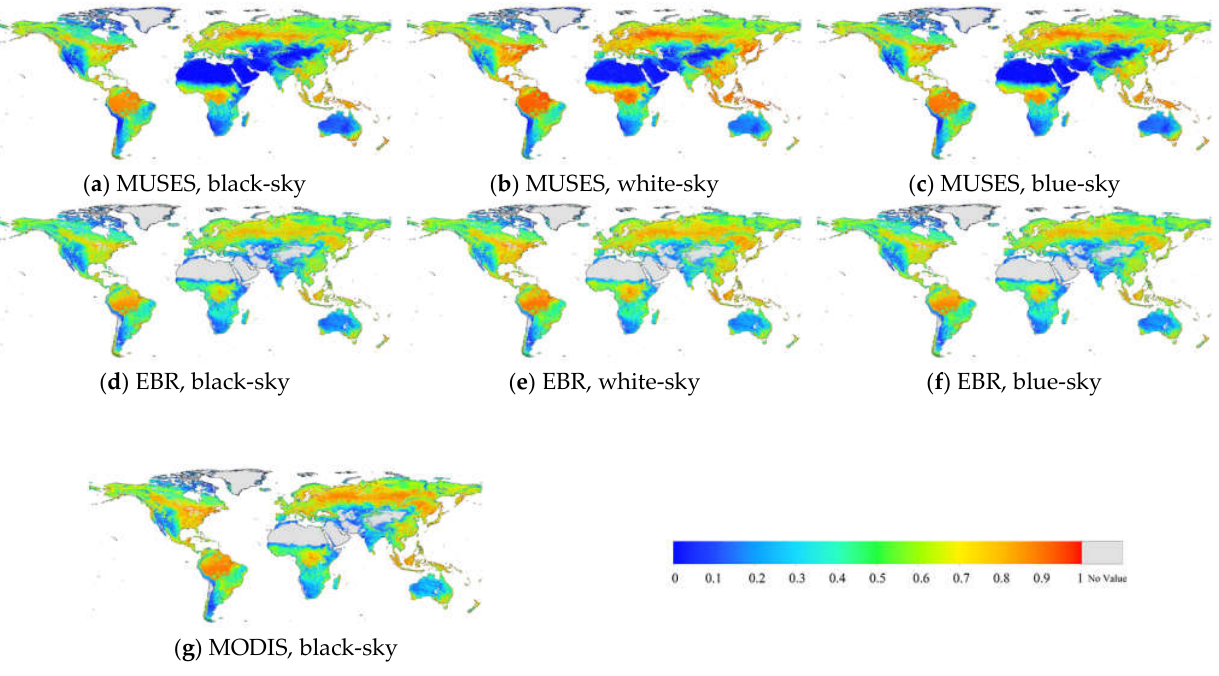
Figure 2. Global spatial maps of MUSES, EBR, MODIS FAPAR products in July of 2016. ( a ) MUSES, black-sky . ( b ) MUSES, white-sky . ( c ) MUSES, blue-sky . ( d ) EBR, black-sky . ( e ) EBR, white-sky . ( f ) EBR, blue-sky . ( g ) MODIS, black-sky .